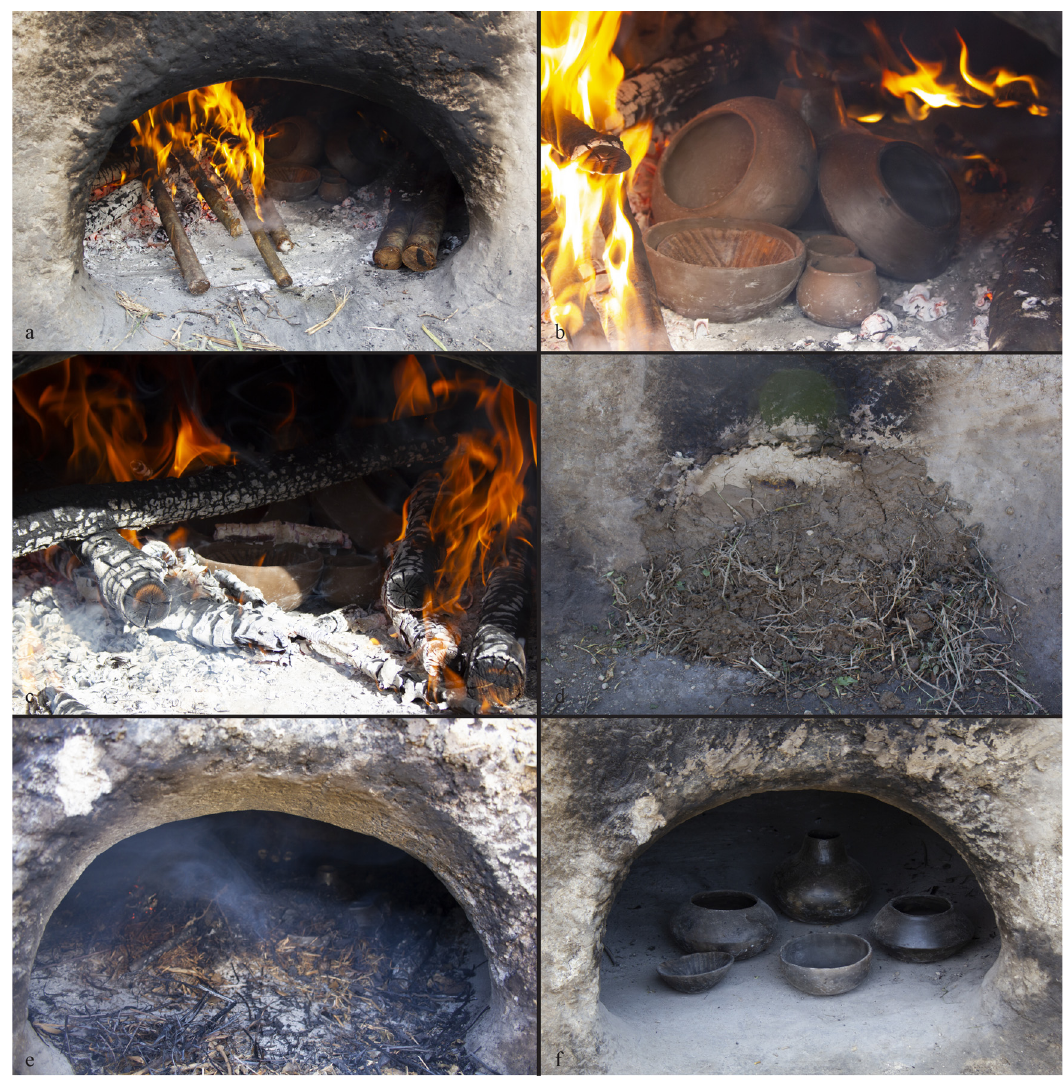
Figure 6: Reducing pottery fi ring ( A ) . ( a and b ) Heating step, ( c ) fi ring, ( d ) reduction step plugging the frontal opening with a mixture of clay and straw, ( e ) opening of the oven after the cooling phase, and ( f ) fi nal